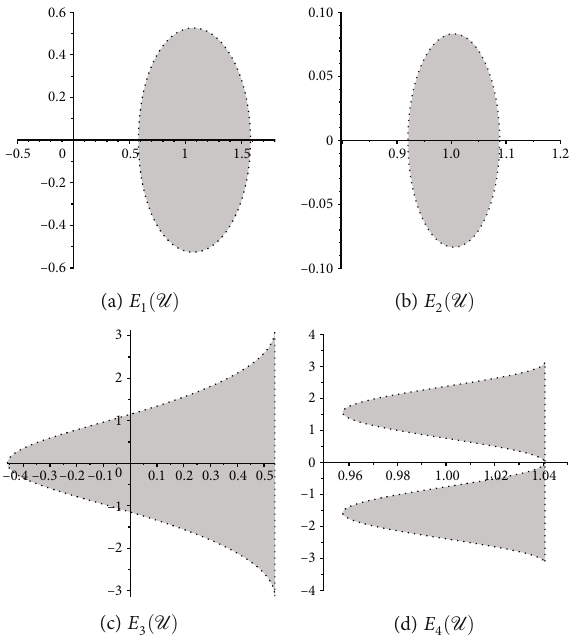
Figure 1: The images of unit disc U by the Einstein functions E